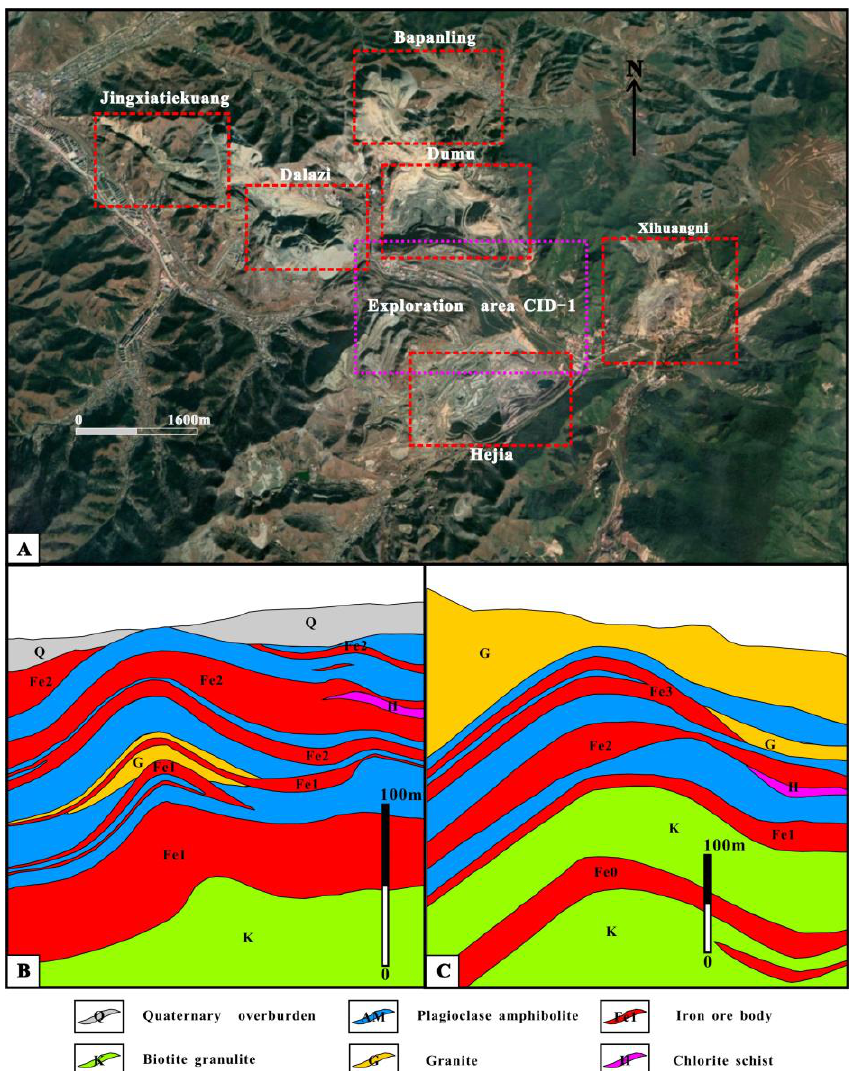
Figure 3. ( A ) Sketch map of the spatial distribution of iron deposits in the Gongchangling area; ( B ) Schematic diagram of a typical geological section showing the spatial distribution and occurrence characteristics of iron ore bodies in the Hejia iron deposit; ( C ) Schematic diagram of a typical geological section showing the spatial distribution and occurrence characteristics of iron ore bodies in the Dumu iron deposit.